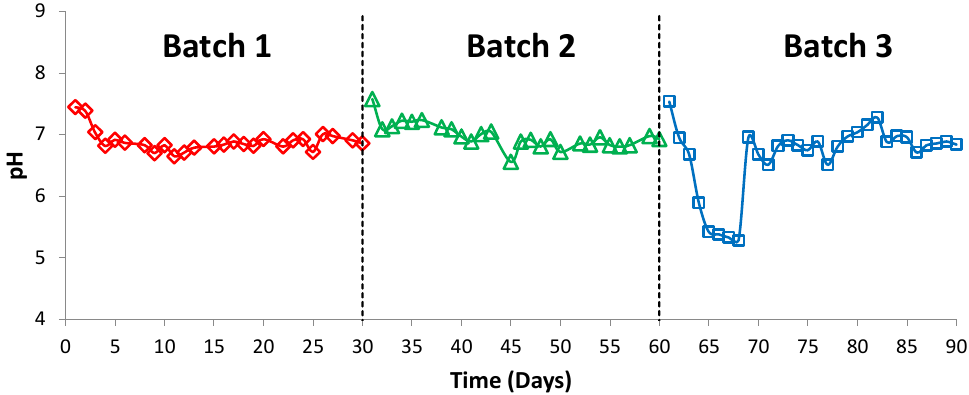
Figure 2. Values of pH during the digestion of SCW with CM. Total COD and soluble COD varied from batch to batch depending on the amount of ISCW that was added. Thus, as shown in Figure 3, the total COD values at the beginning of the three batches were 19.78, 25.18, and 37.34 g/L, respectively. After 30 days of opera- tion, the total COD removals for the three batches were 58%, 50%, and 62%, respectively. Similarly, 60%, 57%, and 35% of the soluble COD were removed from Batches 1, 2, and 3, respectively. Figure 4 shows that, as the CM/ISCW ratio increases, a wider relative differ- ence exists between the total COD and the soluble COD. Anjum et al. [23] noted that, after 42 days of the digestion process, the highest decrease in insoluble COD, i.e., from 30,080 to 14,720 mg/L, was observed at the 50% orange peel ratio with catering waste. This means that 51% of insoluble COD was transformed into soluble COD. Comparing this findings with the results of the present work, the digestion process of ISCW using CM is adequate.